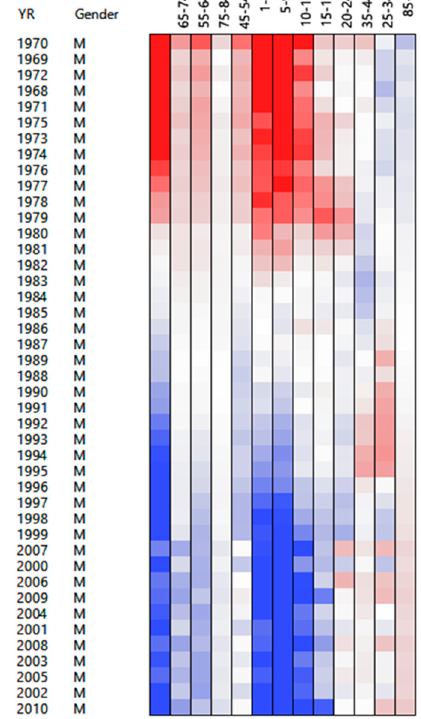
Figure 7. SVD reordering of the rows and columns of a life table. Red: High count; Blue: Low count.